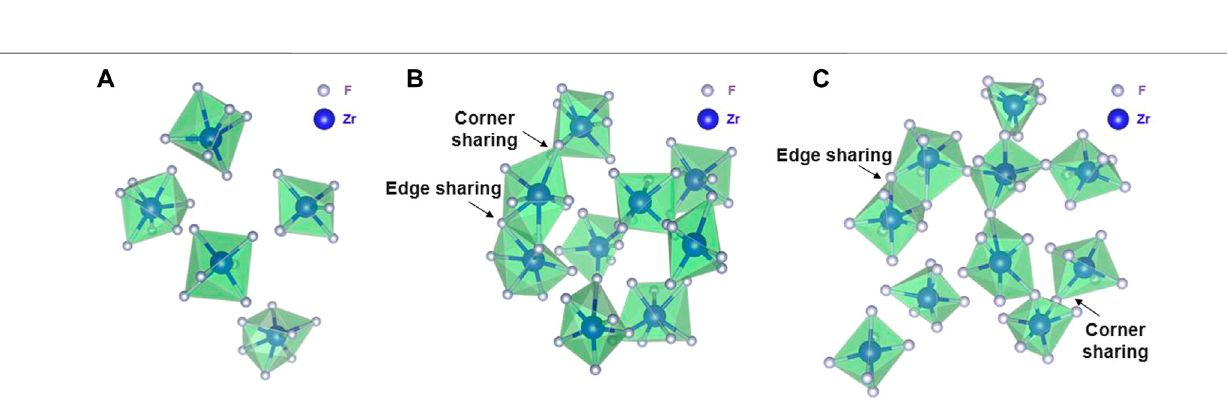
Frontiers in Physics |